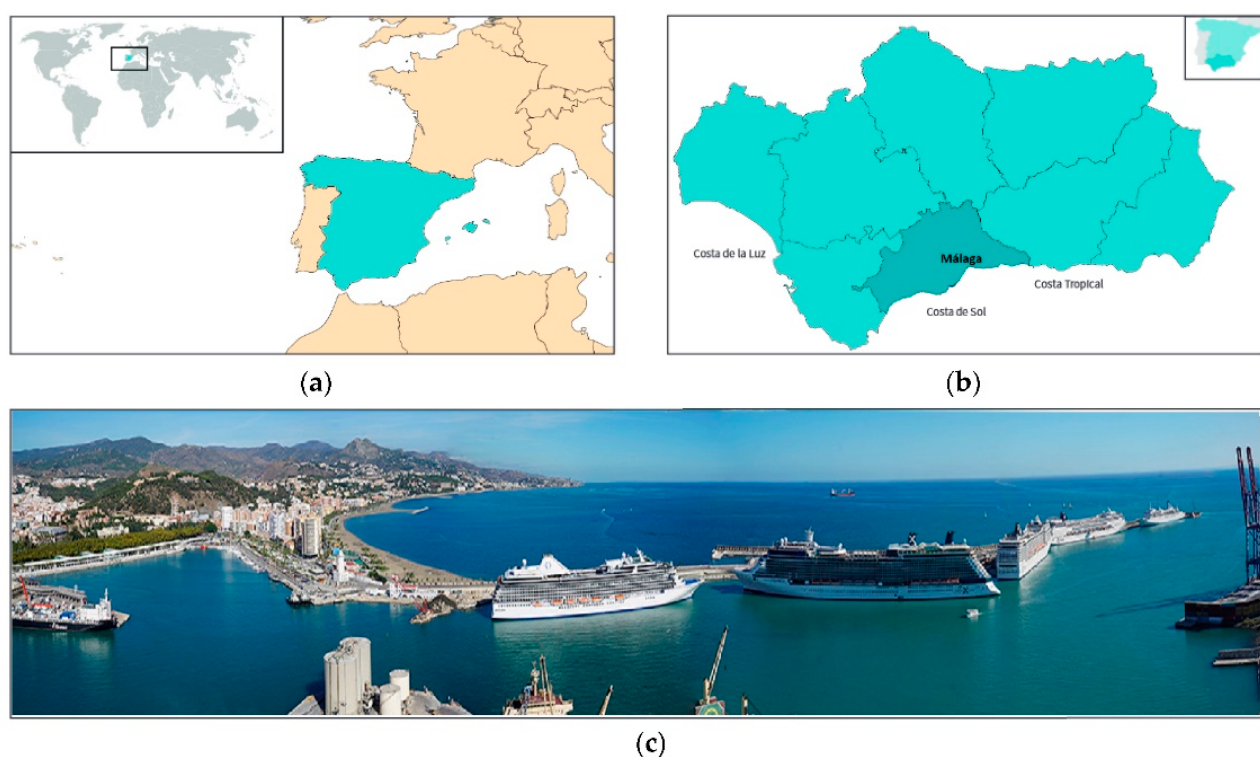
Figure 1. Location of Malaga (Andalusia, Spain) and photo of Port of Malaga. Source: Map ( a ) and map ( b ) from [137], map ( b ) own modification and photo ( c ) [138].